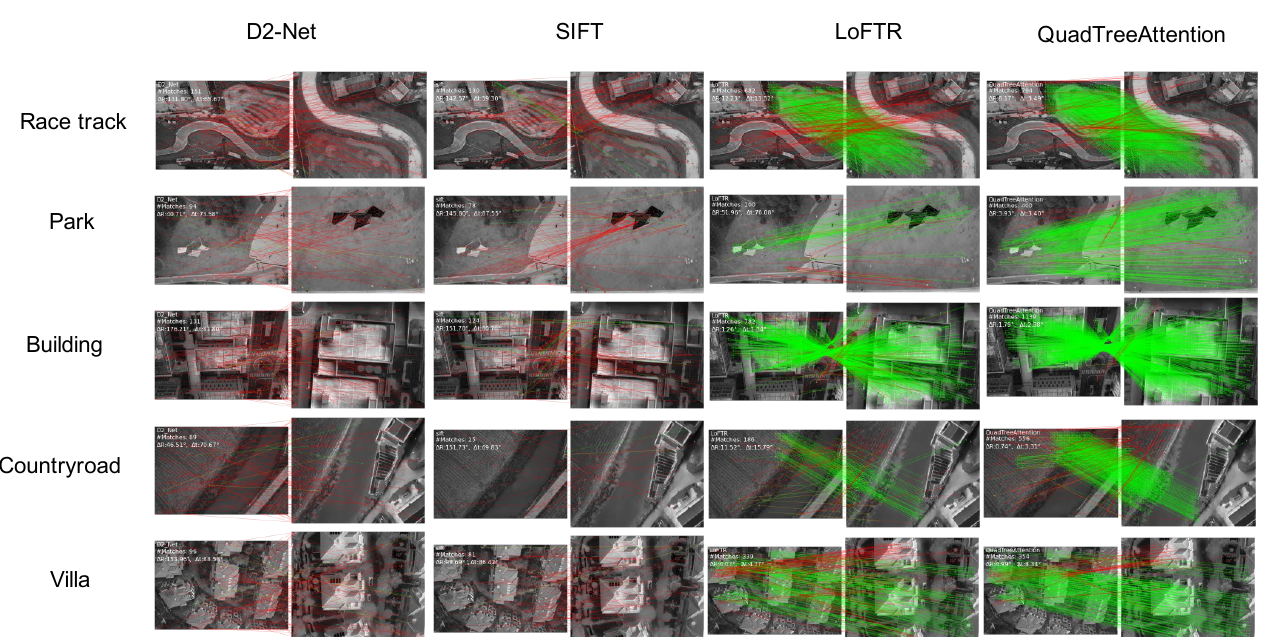
Figure 12. Match results visualization. The green line represents a correct match whose biased estimate of reprojection error is less than the threshold of 5 × 10 − 4 . In contrast, the red line represents an incorrect match. D2-Net and SIFT had almost no correct matches. LoFTR completed many correct matches but also had a large number of incorrect matches.